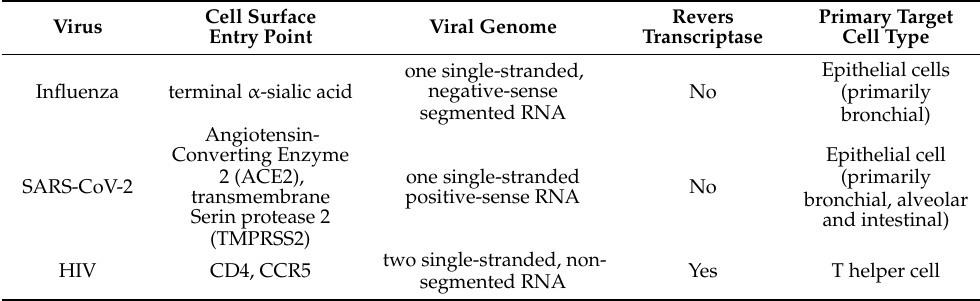
Table 1. Entry points into cells by the three RNA viruses discussed in the present